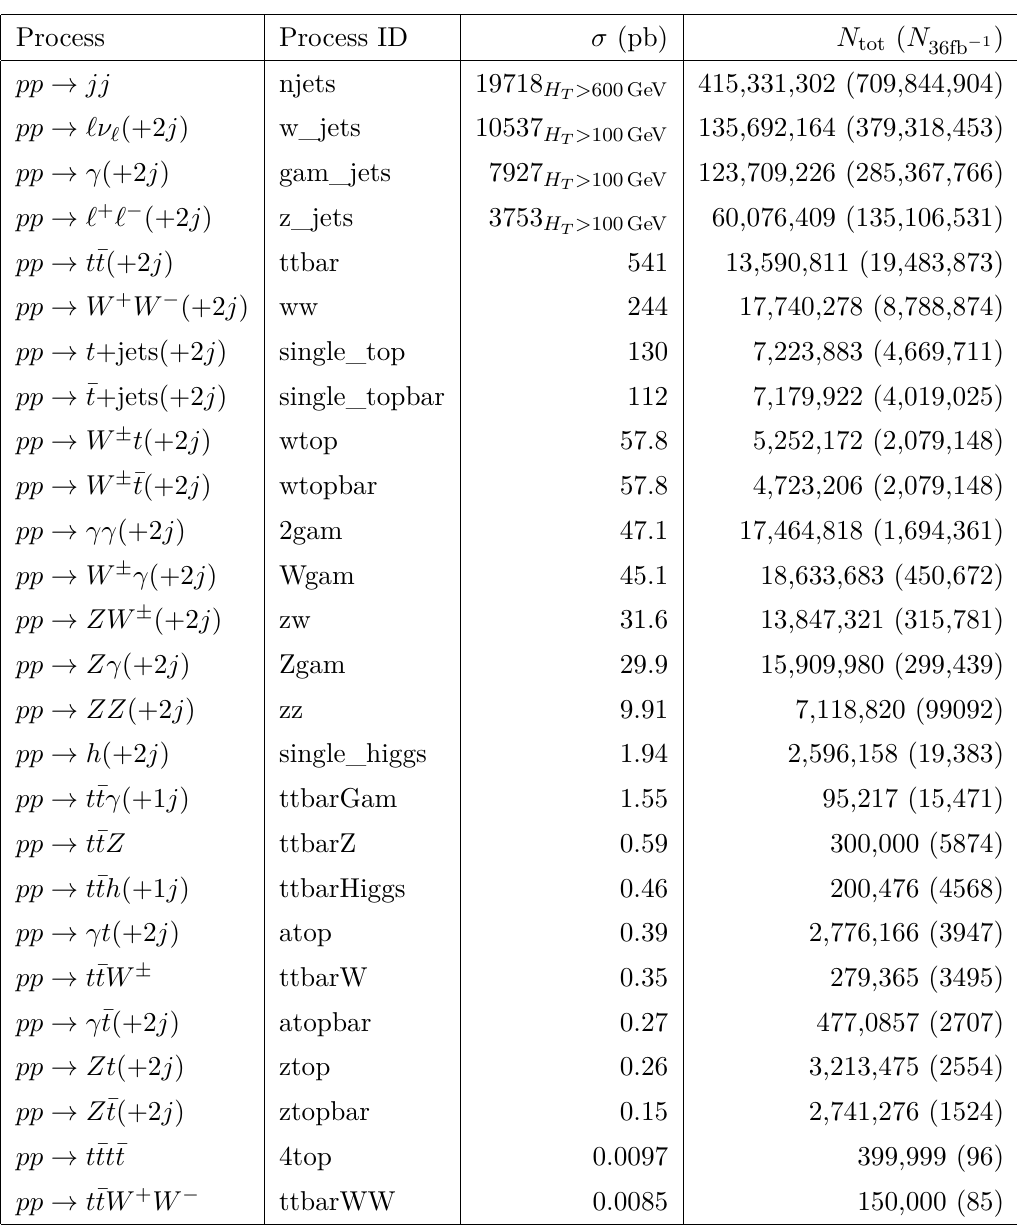
Table 2 . Summary of the background processes included in the analysis. The details include the √ production cross-section at s = 13 TeV, the number of events that were generated, and the number of events expected in 36 fb − 1 of LHC data [38]. To account for interference effects, the njets sample also contains electro-weak exchanges (i.e. with a Z , W ± or photon). Then the remaining leptonic productions of Z/γ s-channel processes are included in pp → l + l −